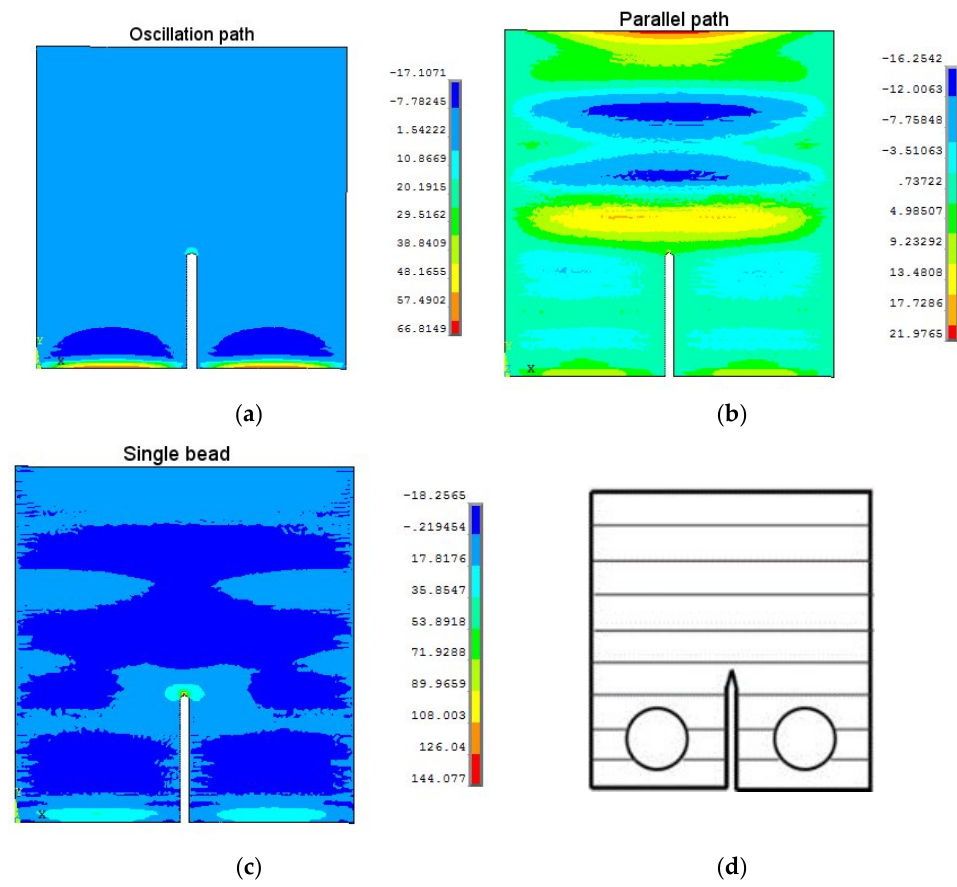
Figure 10. FE stress maps of CT coupons with crack across the build layers: ( a ) oscillation path (60 mm × 62.5 mm), ( b ) parallel path (76 mm × 80 mm), ( c ) single bead (76 mm × 80 mm), ( d ) sketch of the crack orientation (unit: MPa).